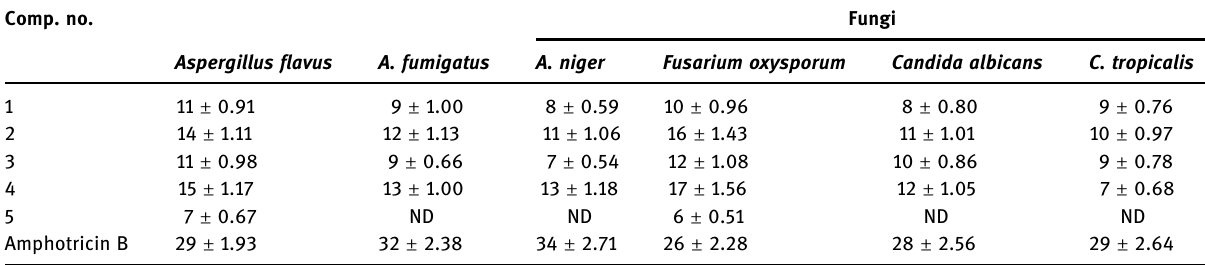
Table 4: Diameter of inhibition zone in mm at concentration level of 10 µg/mL of the compounds 1 – 5 Comp.